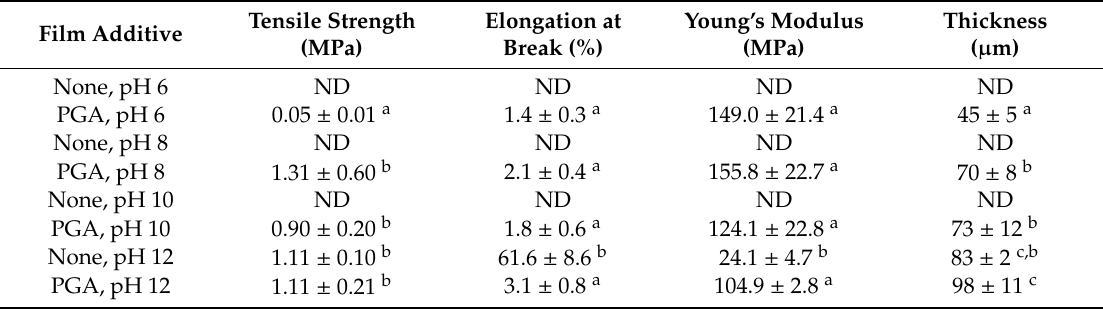
Table 4. E ff ect of poly- γ -glutamic acid (PGA) on the mechanical properties of whey protein (WP) films prepared at di ff erent pHs and containing 50% GLY